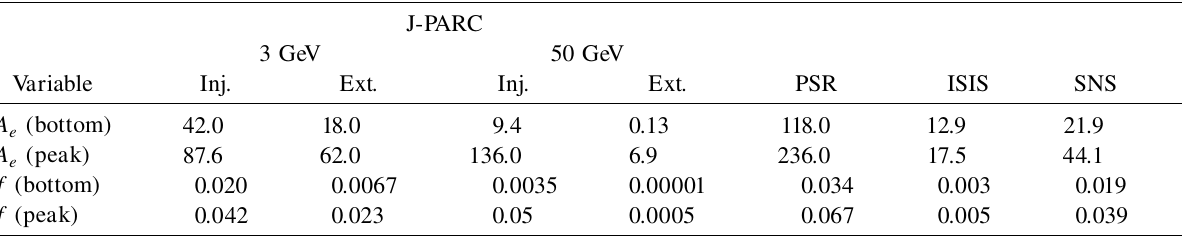
TABLE II. Electron cloud buildup of the proton